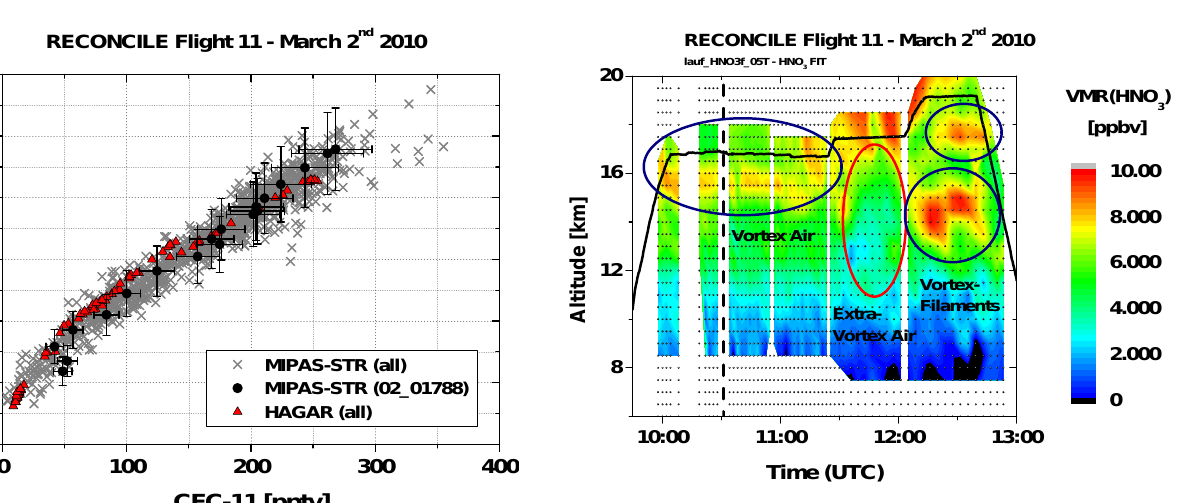
Fig. 18. Vertical cross-section of HNO 3 along flight track de- rived from MIPAS-STR measurements. The turn between the north- eastern flight leg (from Longyearbyen) to the southward flight leg (towards Kiruna) is indicated by the dashed vertical line. Retrieved HNO 3 -mixing ratios are linearly interpolated between the retrieval grid points (black dots) and are shown colour-coded. Interpolation is performed between grid points with vertical resolutions of the result of better than